Question: Is the quantity shown trending increasing or decreasing?
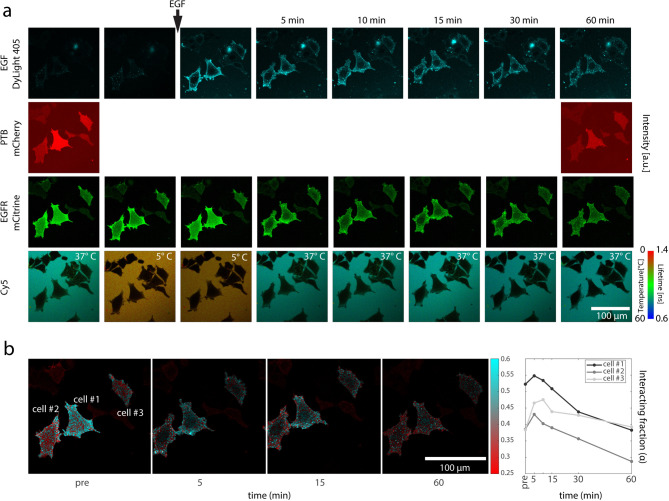
Answer: increasing